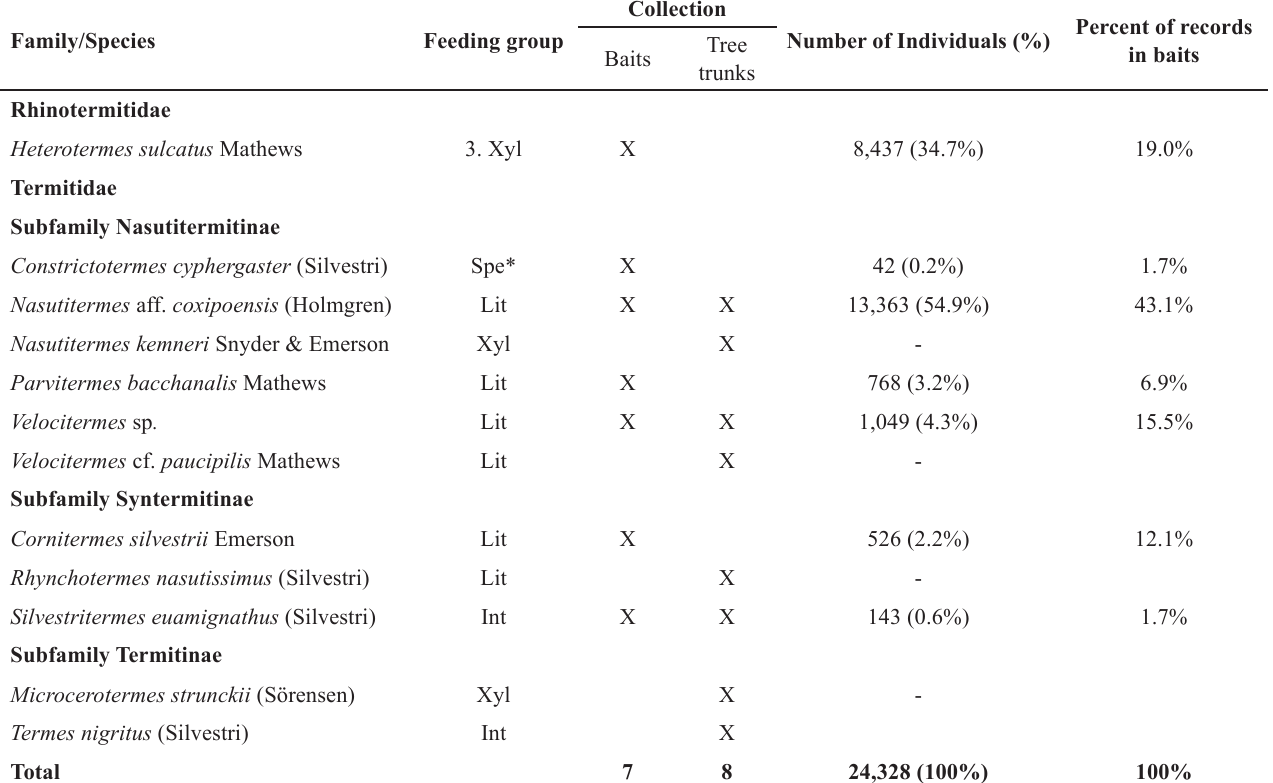
Table 2. Termite species found in the Cerrado of the Estação Ecológica de Pirapitinga and their relative abundance and frequency in baits and in tree trunks. Feeding groups (according to Constantino 2015): Xyl = xylophagous, wood-feeder; Lit = litter-feeder; Int = intermediate (species that feeds on wood and litter); Spe* = specialized feeder.